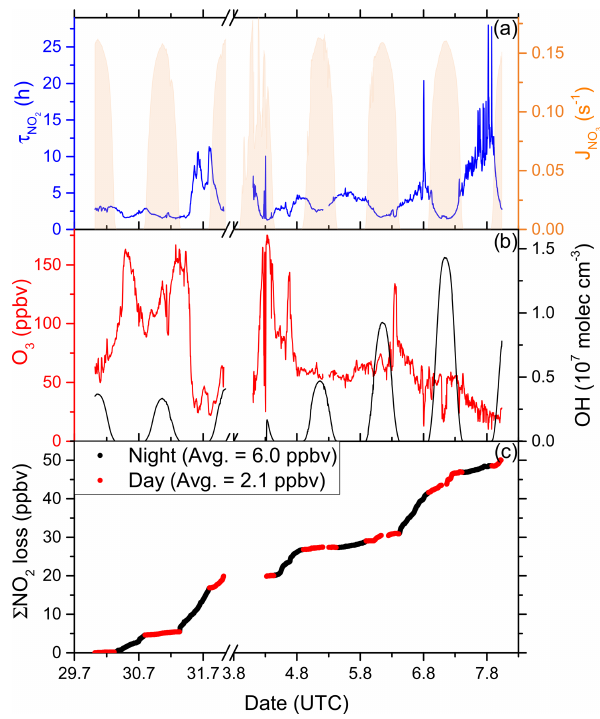
Figure 12. (a) Lifetime ( τ ) of NO 2 due to reactions with OH and O 3 in the Arabian Gulf , together with concentrations of O 3 and OH. The OH trace is an interpolation based on OH measurements and J (see Sect. 3.3.3). Daytime hours are indicated via J NO O 1 D (b) Cumulative loss of NO 2 during the displayed time frame, based on the calculated lifetimes and measured NO 2